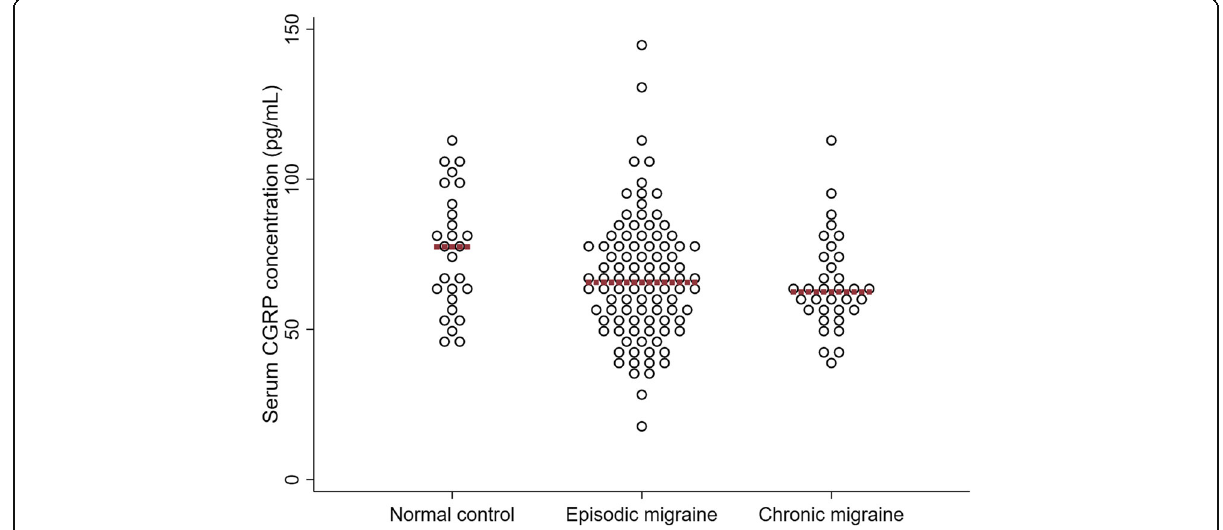
Fig. 1 Interictal serum CGRP concentration in different groups. Dots represent individual values. Red line indicates the median of each